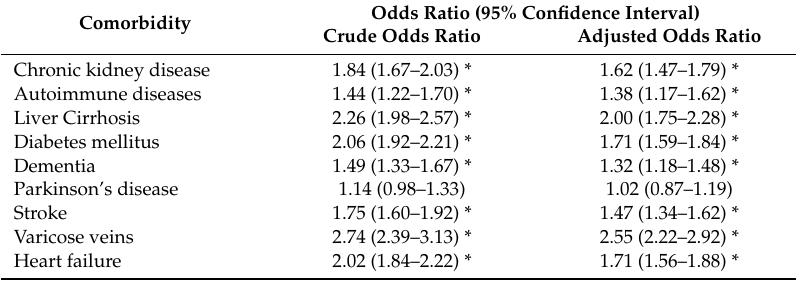
Table 3. The association between medical factors and cellulitis after acupuncture in propensity matching